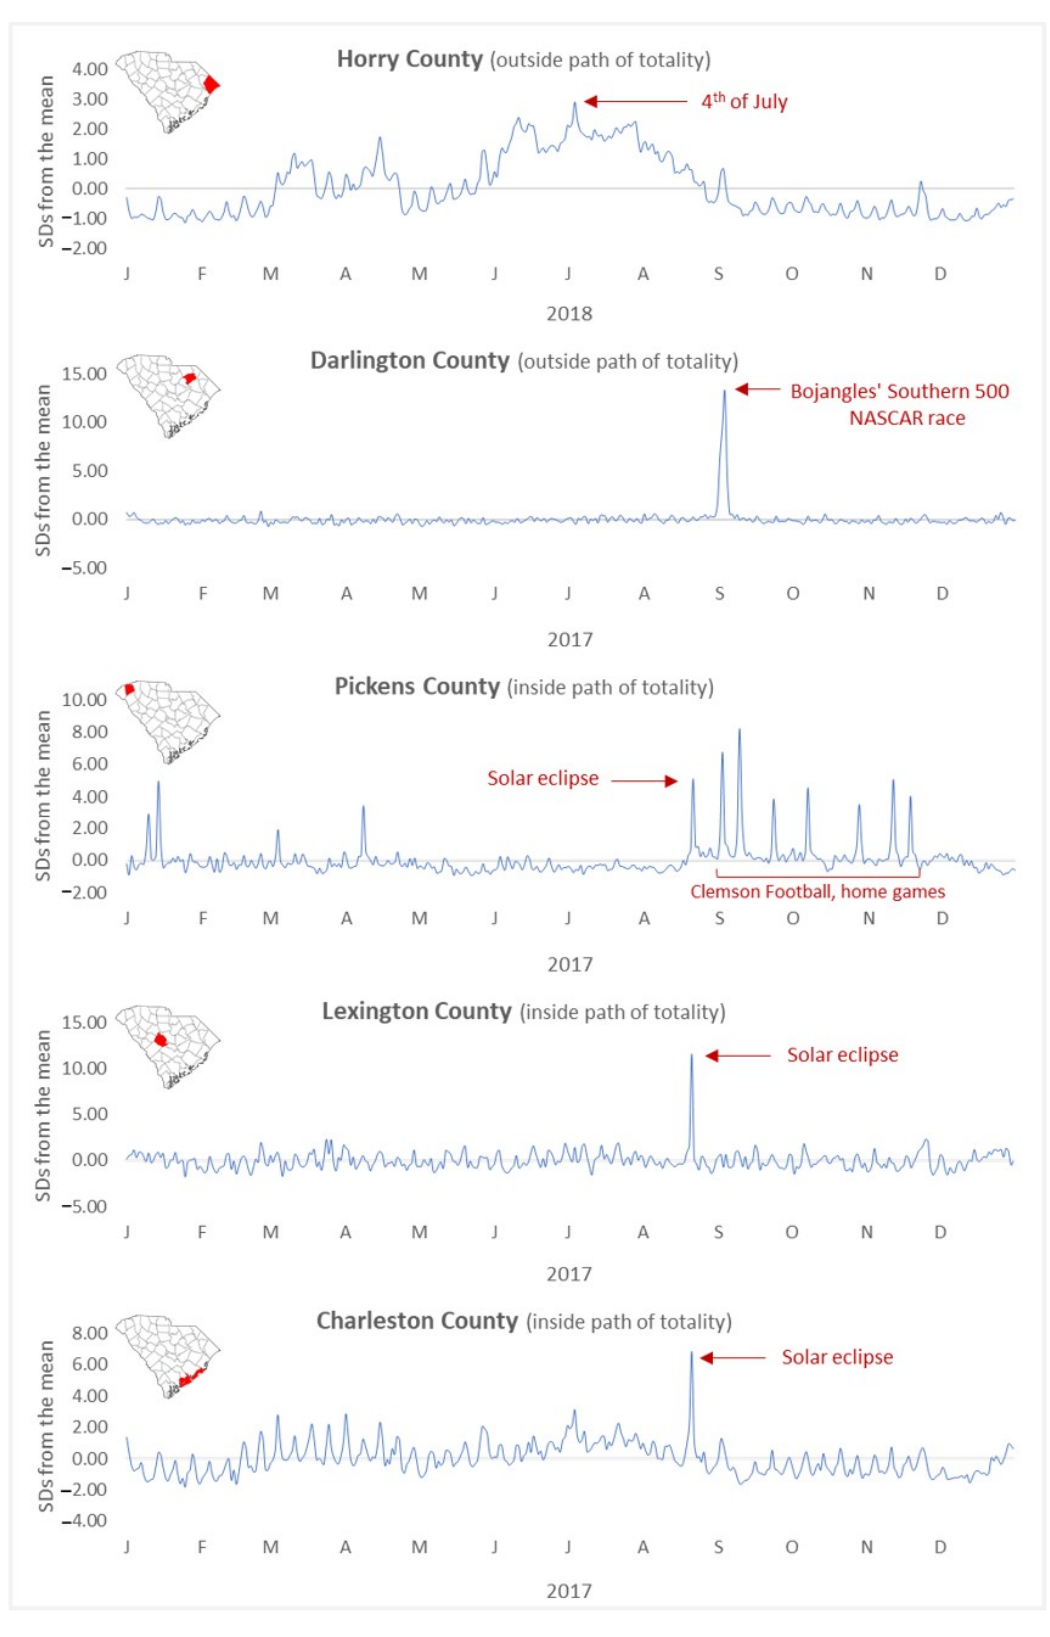
Figure 5. Annual distribution of Twitter non-residents (expressed in daily standard deviations from the mean) for five SC counties: outside of the path of totality (Horry County and Darlington County) and inside of the path of totality (Pickens County, Lexington County, and Charleston County).